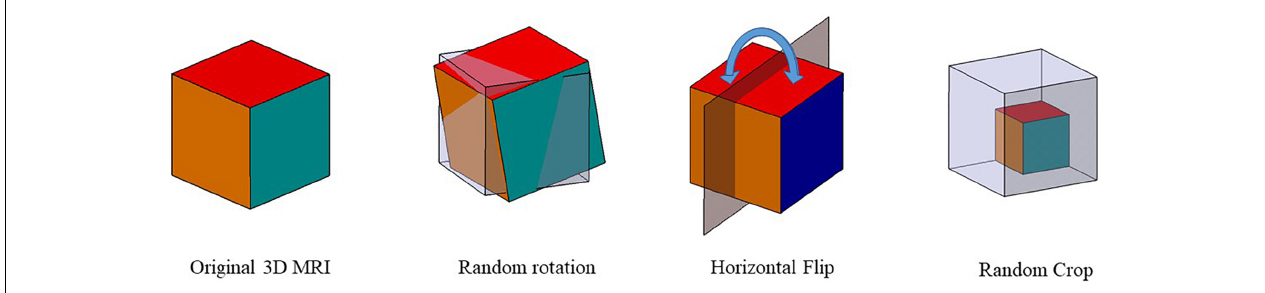
FIGURE 4 | Data augmentation schematic. Three data augmentation were used to augment the data size: random rotation, horizontal flip, and random